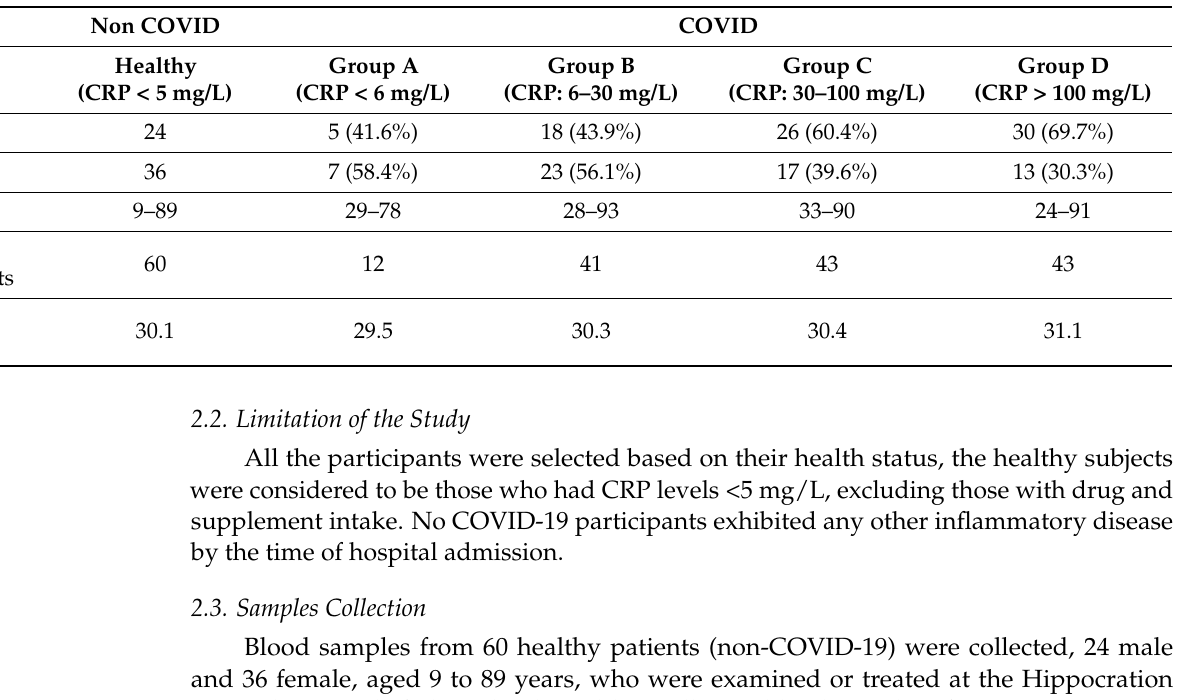
Table 1. Characteristics of patients Age, Male/female, Severity of the